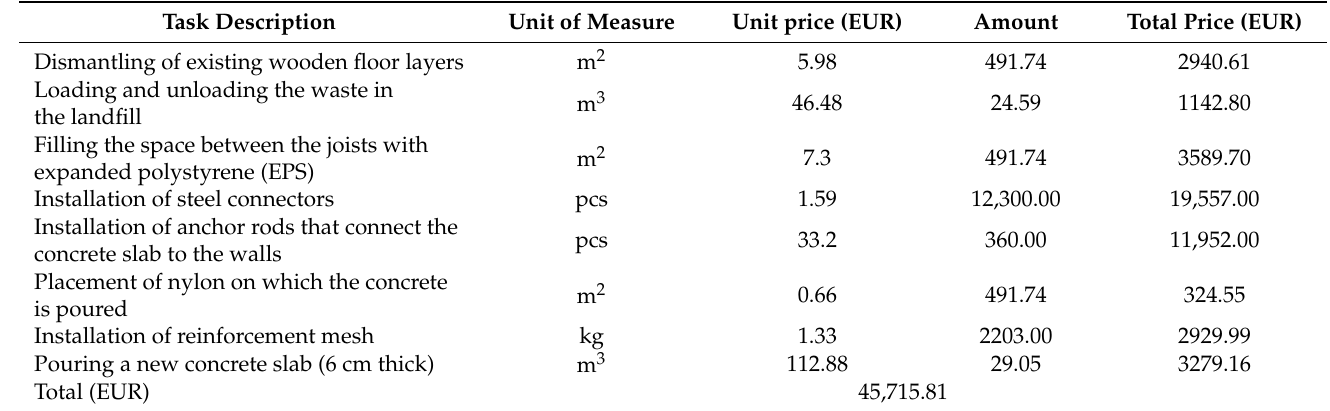
Table 8. Calculation of renovation costs—rigid diaphragm on the first floor.